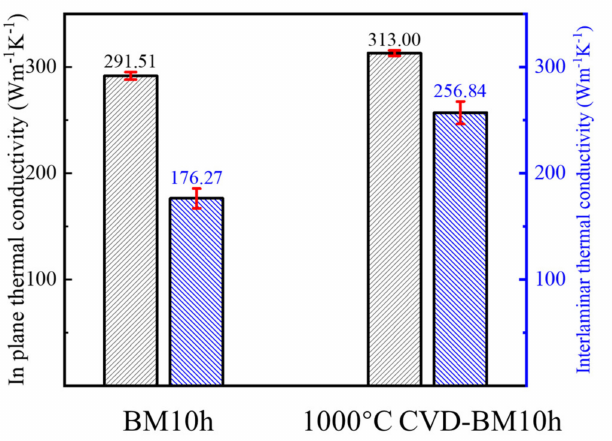
Figure 15. Thermal conductivity characterization results of composites made by BM10h and 1000 ◦ C